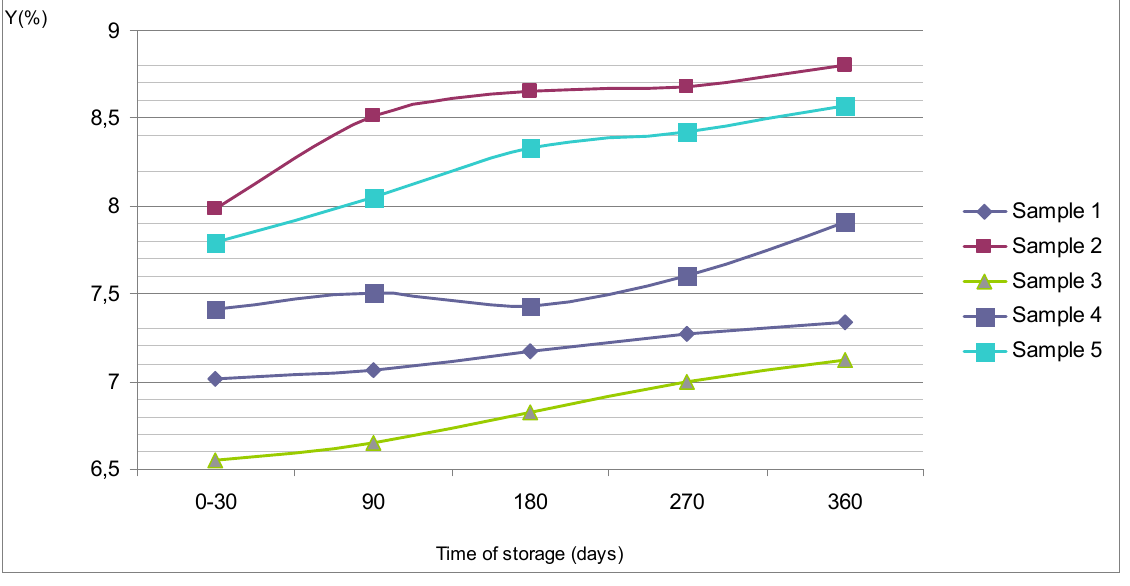
Figure 3. Changes of average reflectance (Y, %) on the bottom surface of samples of dietary chocolates during storage of 360